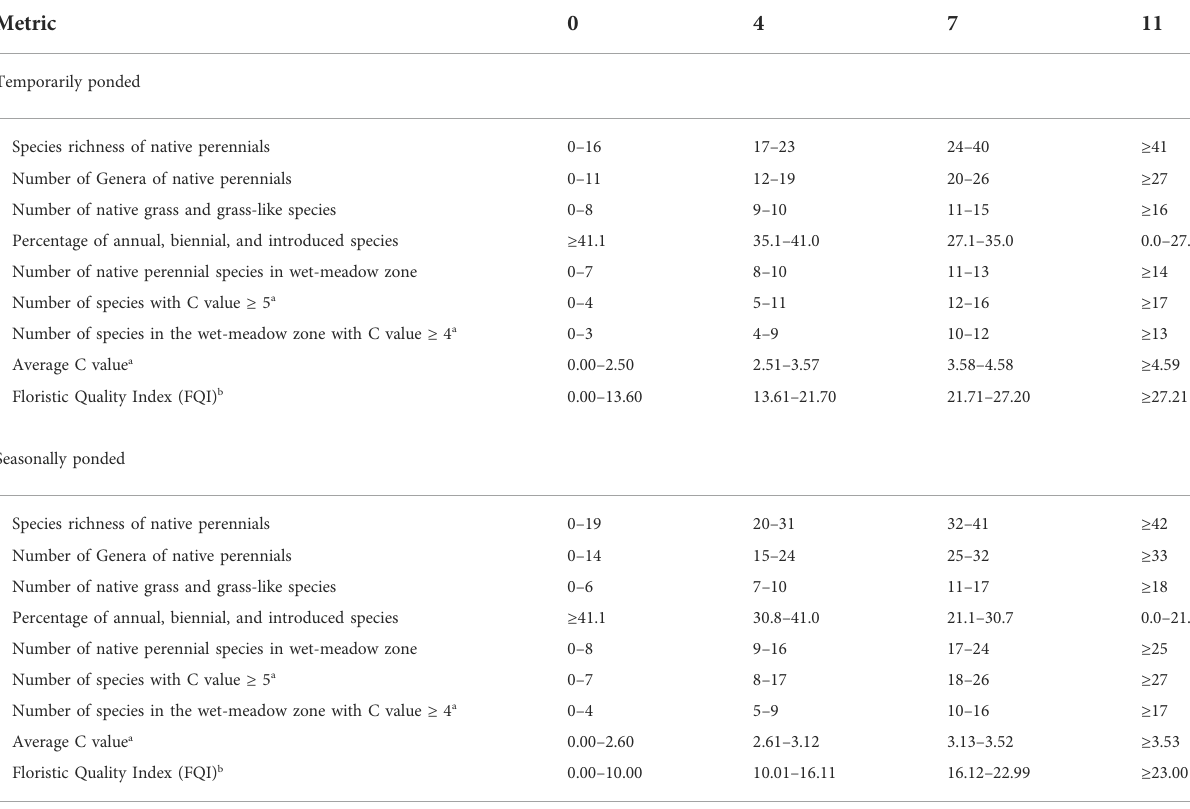
TABLE 1Index of Plant Community Integrity metric value ranges for scores of 0, 4, 7, and 11 for temporarily ponded and seasonally ponded wetlands of the Prairie Pothole Region of North America (see Hargiss et al., 2008).